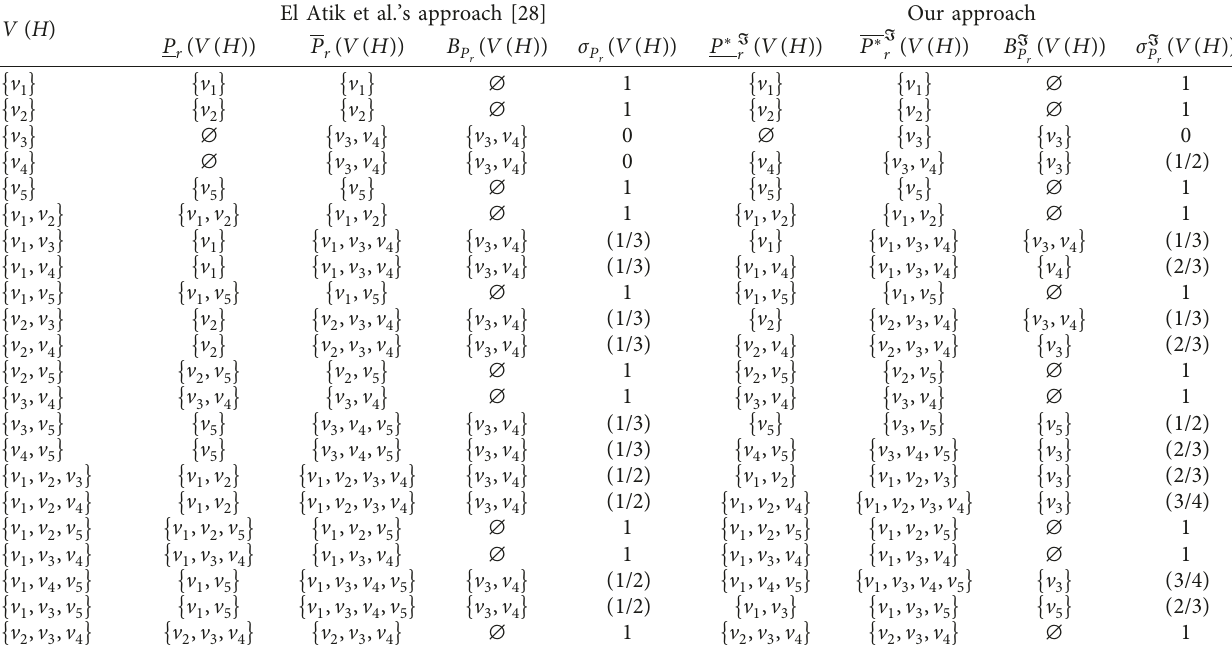
Table 3: Comparisons between the lower approximations, upper approximations, j -boundary, and j -accuracy measures by using El Atik et al.’s approach [28] and our approach for j � r